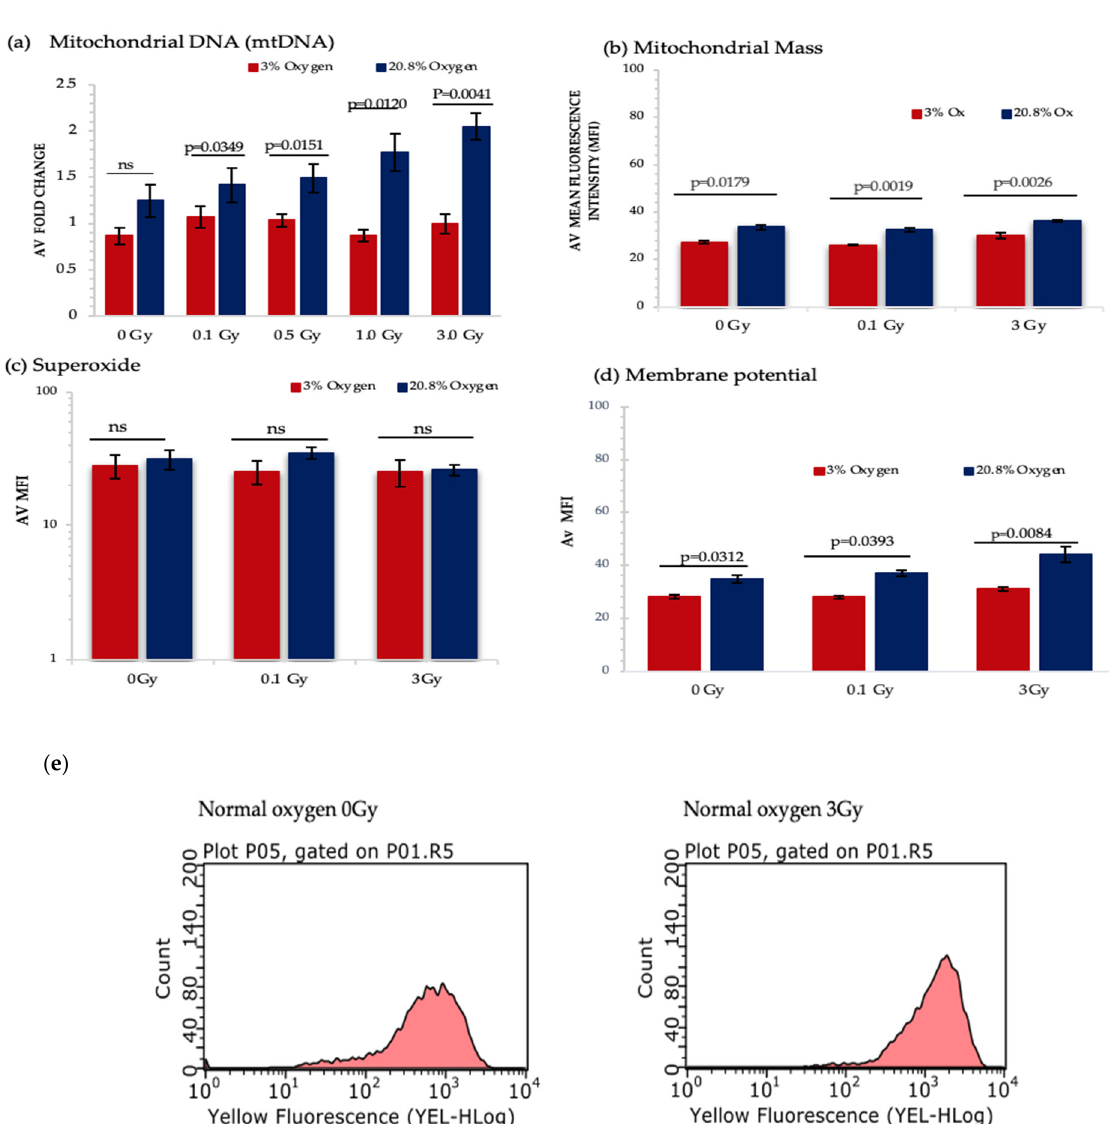
Figure 6. Represents the analysis from different mitochondrial functionality assays. HSPCs for each assay were extracted from expansion cultures at day 7. Different oxygen levels and radiation doses were compared to assess the influence on mitochondrial function. ( a ) Mitochondrial DNA- N 3; ( b ) Mitochondrial Mass- N 3, ( c ) Mitochondrial Superoxide- N 4, ( d ) Mitochondrial Membrane Potential- N 4. ( e ) Flow cytometric profiles of JC-1 displaying mean fluorescence intensity of non-IR and 3 Gy- exposed HSPCs under normoxia. Error bars represent ±SEM. ANOVA and multiple comparison test applied.